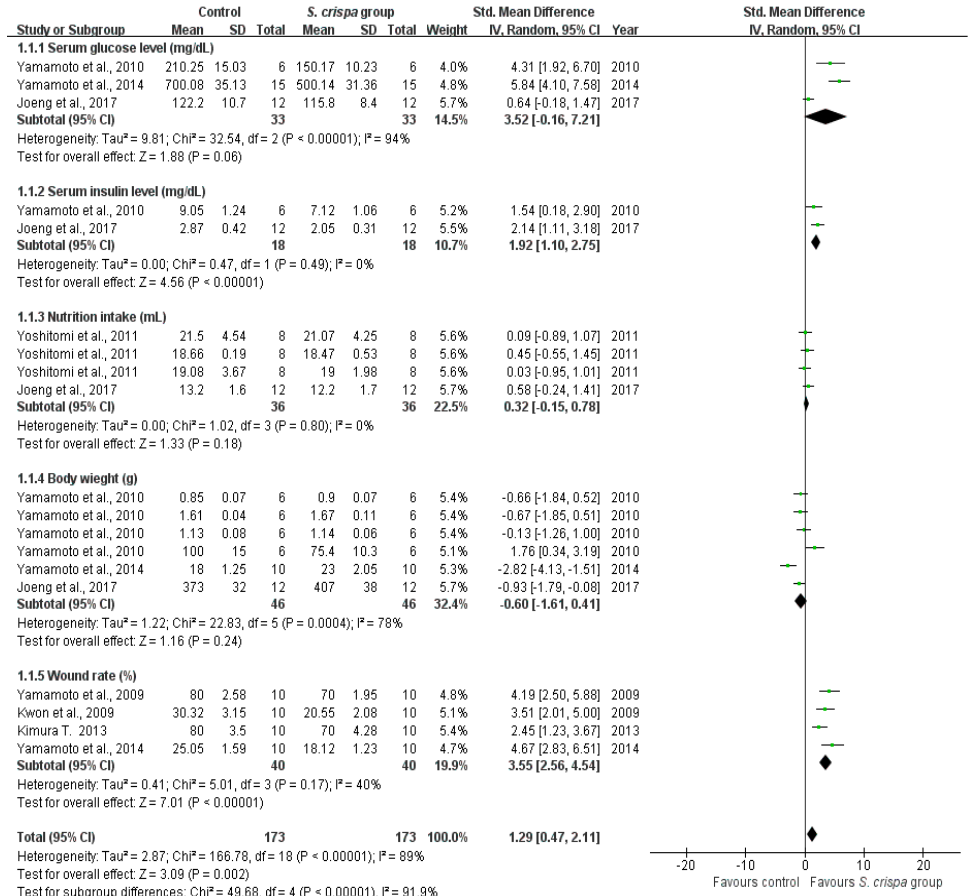
): SMD of Figure 4. Comparison of the survival of cancer cells between control and S. crispa groups. ( ): SMD